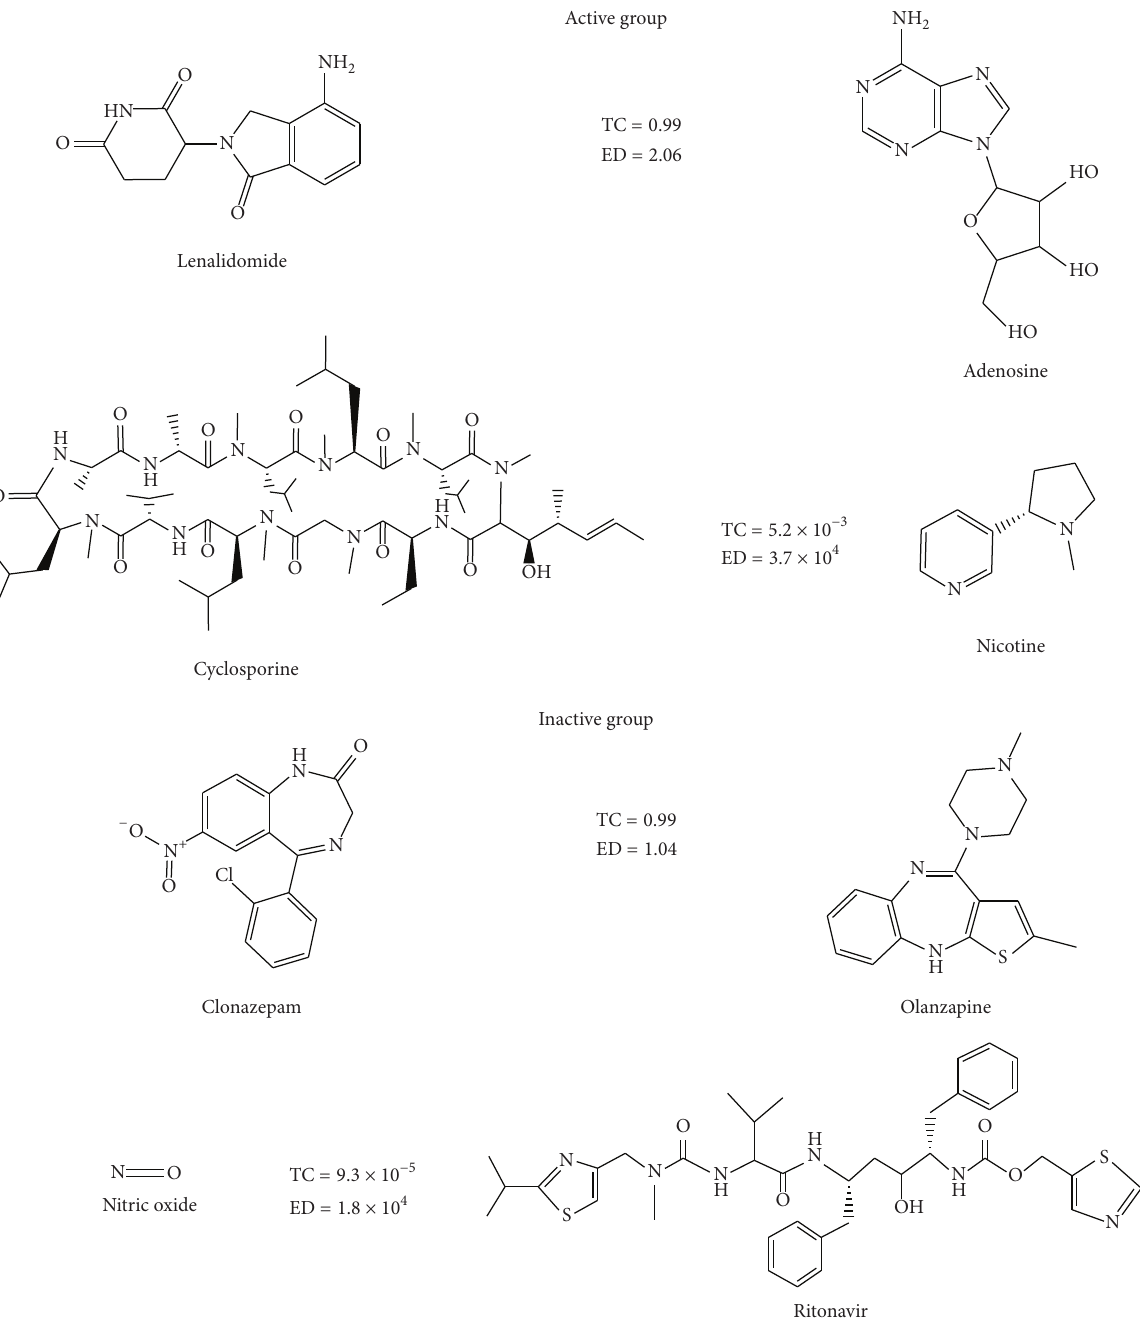
F 2: Results obtained from the molecular similarity study. TC: Tanimoto coefficient and ED: Euclidean distance.